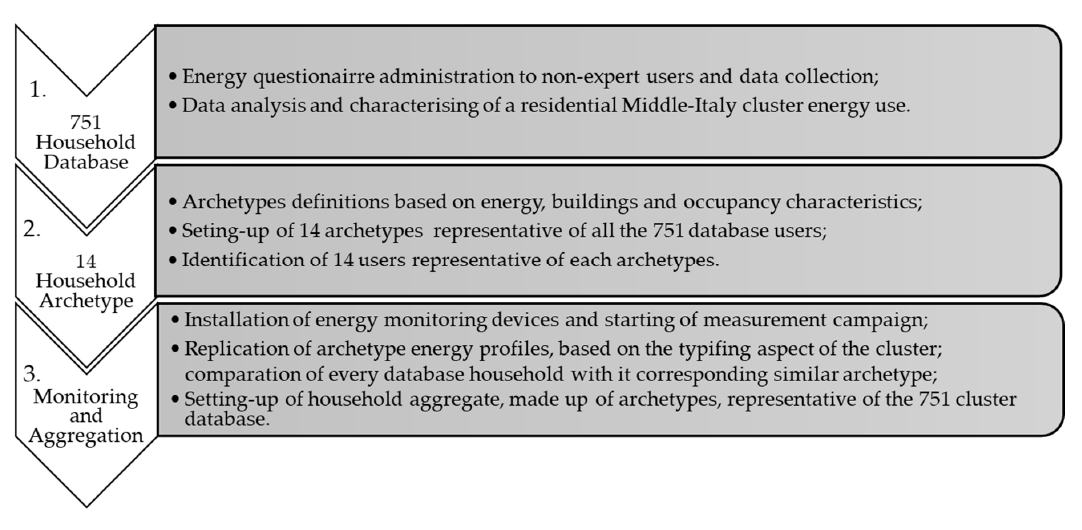
Figure 1. Flow chart related to the methodological approach.